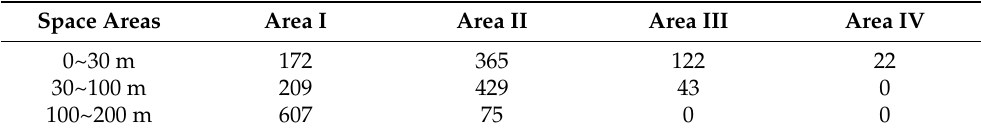
Figure 6. Comprehensive evaluation diagram of underground space resource development suitability (100~200 m). Table 3. Distribution table of underground space resource quantity evaluation. Space